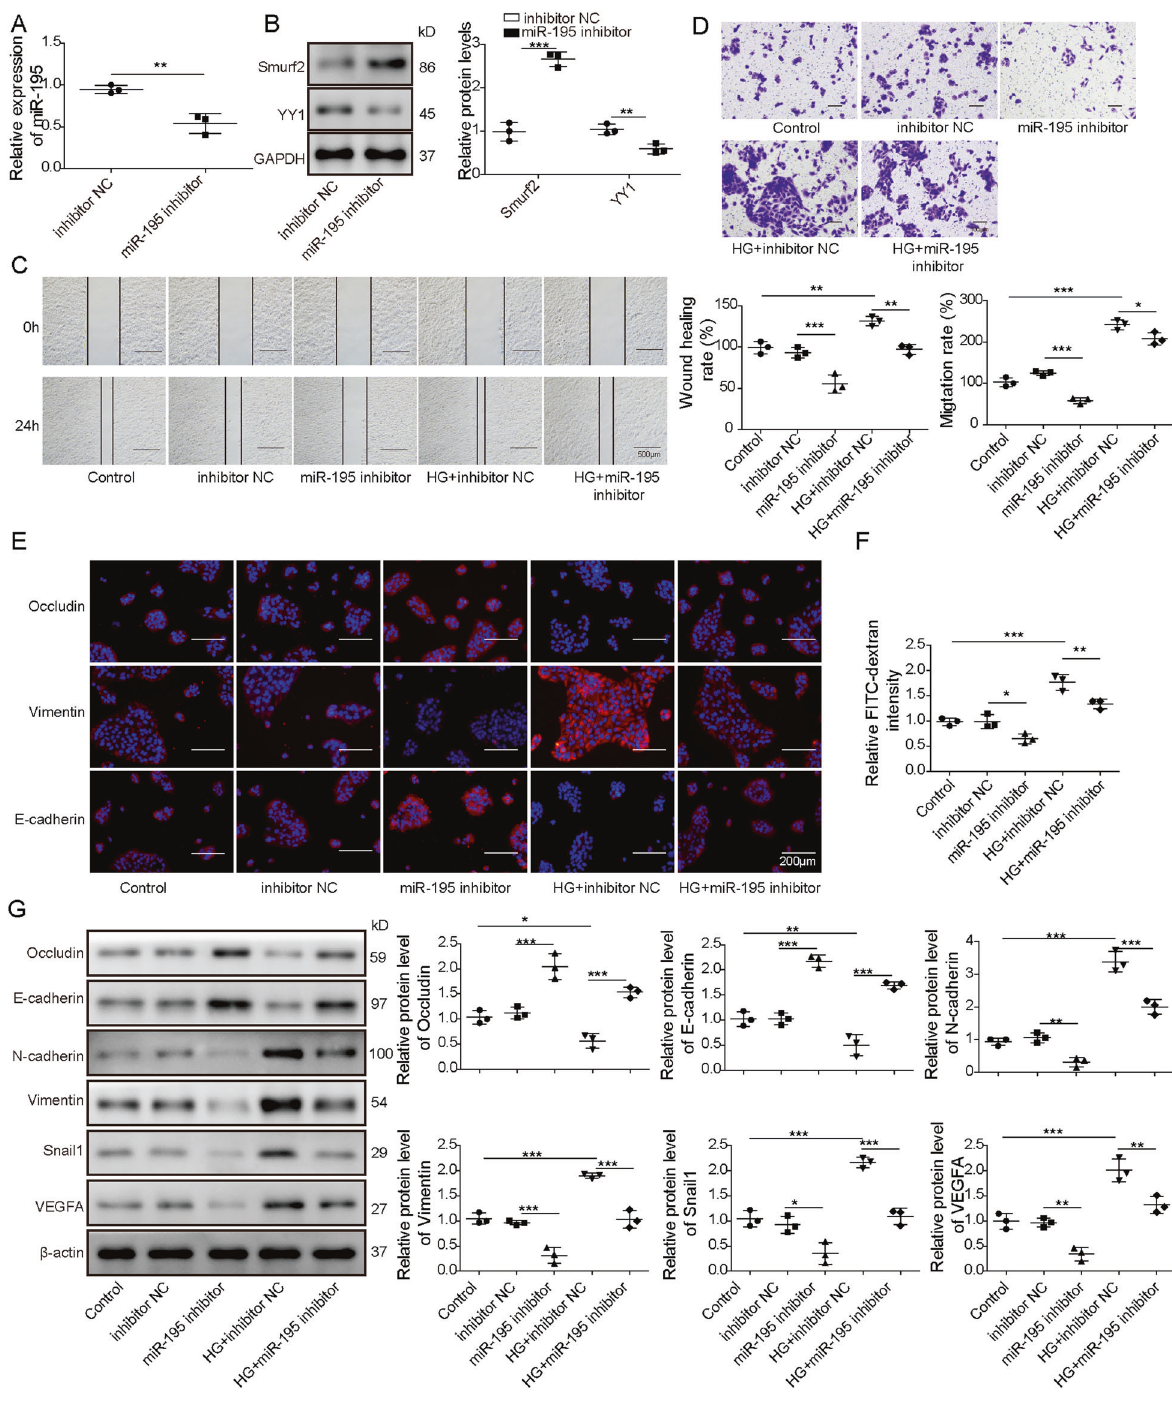
Fig. 5 MiR-195 knockdown upregulates Smurf2 to inhibit YY1 and represses HG-induced EMT and cell permeability of ARPE-19 cells. ARPE-19 cells were transfected with inhibitor NC or miR-195 inhibitor, and were then stimulated or not stimulated by HG. A MiR-195 abundances were measured via qRT-PCR in the transfected cells. B Smurf2 and YY1 abundances were measured via western blotting in the transfected cells. C , D Cell migration was measured using wound-healing analysis and transwell assay in the treated cells. E Occludin, E- cadherin, and Vimentin abundances were determined by immuno fl uorescence in the treated cells. F Cell permeability was evaluated via FITC- dextran assay in the treated cells. G VEGFA, Snail1, Occludin, E-cadherin, N-cadherin, and Vimentin levels were detected via western blotting in the treated cells. For each analysis, three technical replicates were performed and three biologically independently performed replicates are included, * p < 0.05, ** p < 0.01, *** p <